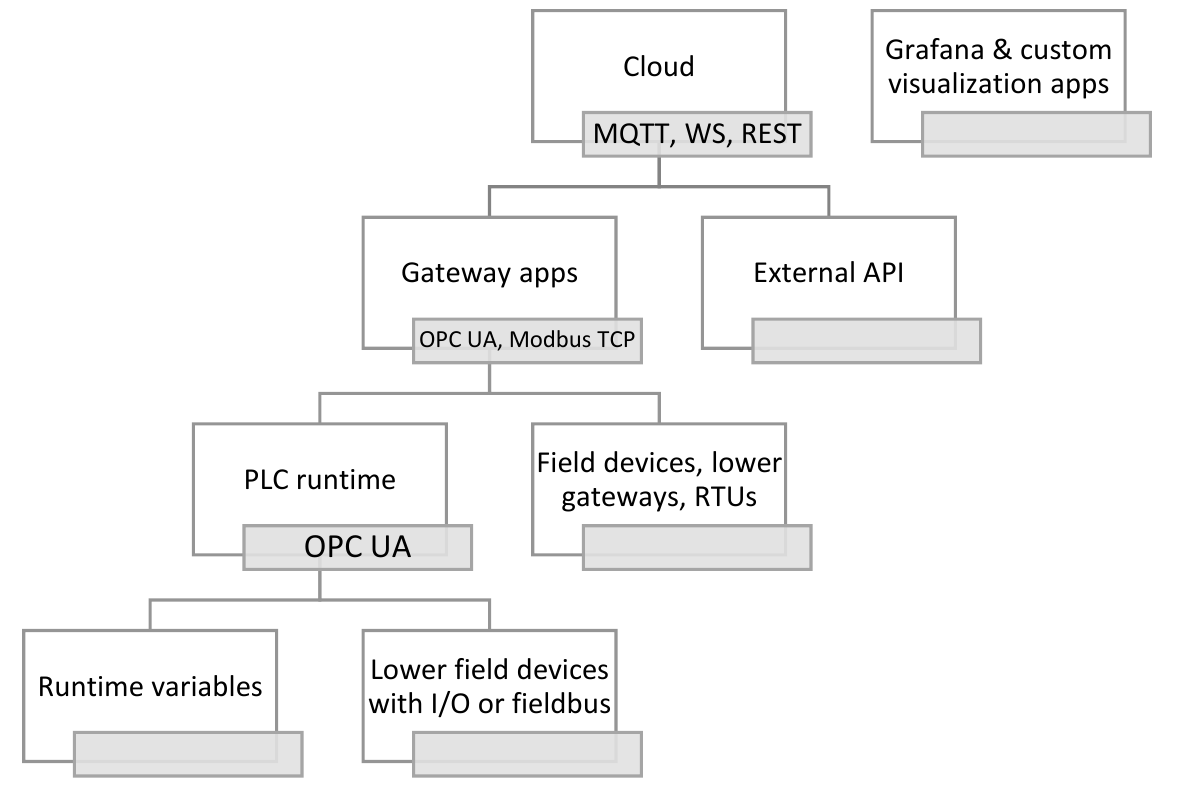
Figure 1: Architecture description – from field to cloud